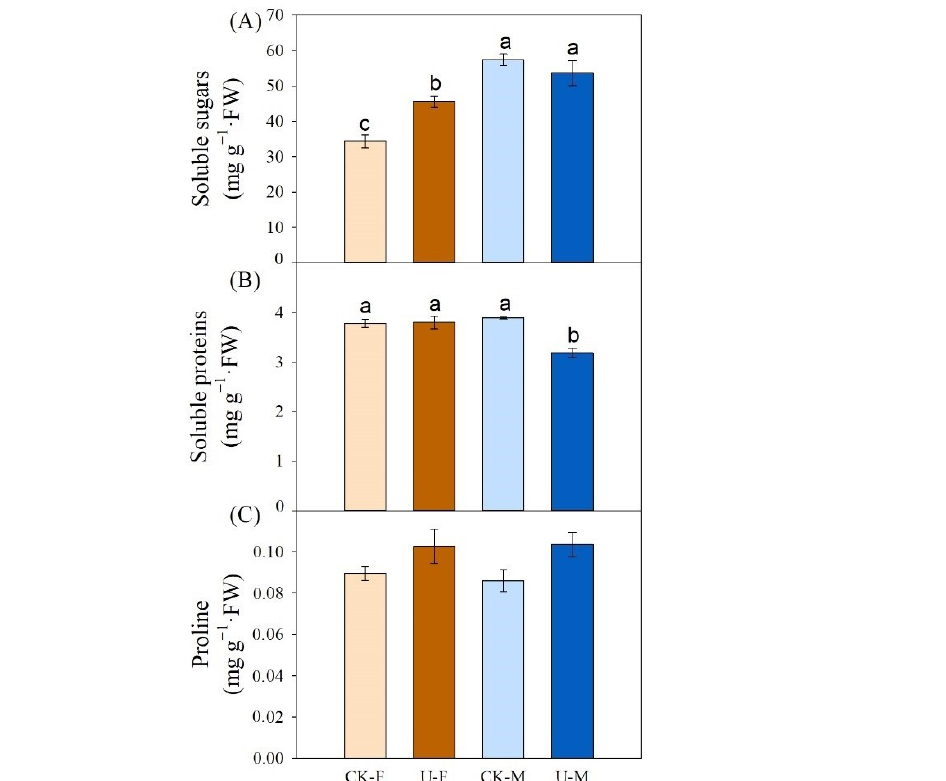
9 of 13 Figure 5. Female and male trees of P. cathayana : MDA ( A ), H 2 O 2 ( B ), and the activity of antioxidant enzymes POD and SOD ( C , D ). Values are expressed as means ± SE ( n = 3). Different letters repre- sent significant differences between treatments ( p < 0.05).